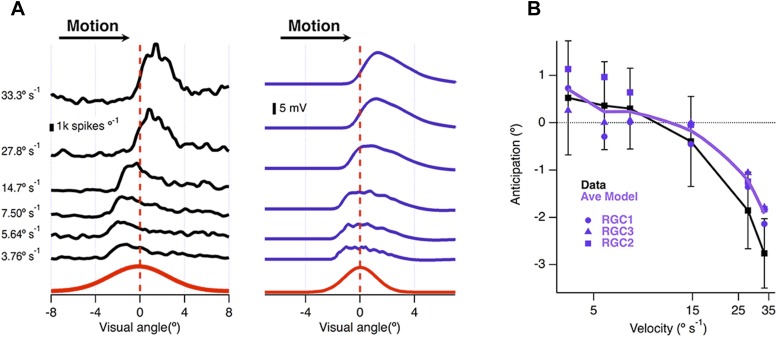
Velocity-dependence of motion anticipation.(A) Black traces show the spike histograms from a single cell for a 160 µm bar moving at different velocities plotted against the position of the leading edge relative to the RF centre (average of 30 presentations). Purple traces show the average response of the model (RGC2) to the same stimulus parameters, with an I/E ratio of 2.04:1. Note that the peak EPSP starts to lag behind the receptive field centre at higher velocities. (B) The average amount of anticipation plotted against velocity for 26 OFF ganglion cells (black, ±SD). Motion anticipation operated until a velocity of about 1 mm s−1, as also predicted by the three models (purple).